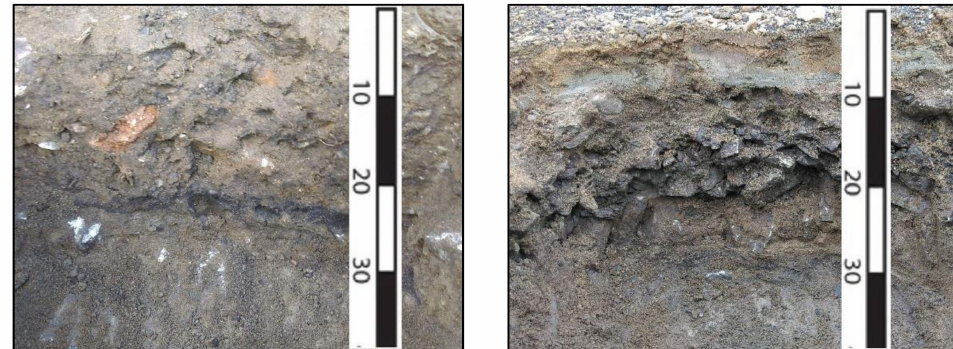
Figure 2. Soil profile in the contaminated